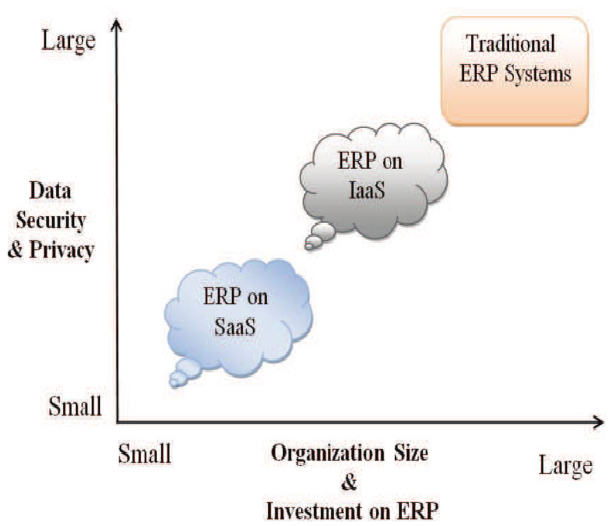
Figure 2. ERP system adoption [37]. (Reprinted with permission from ref. [37]. Copyright 2014 IEEE)